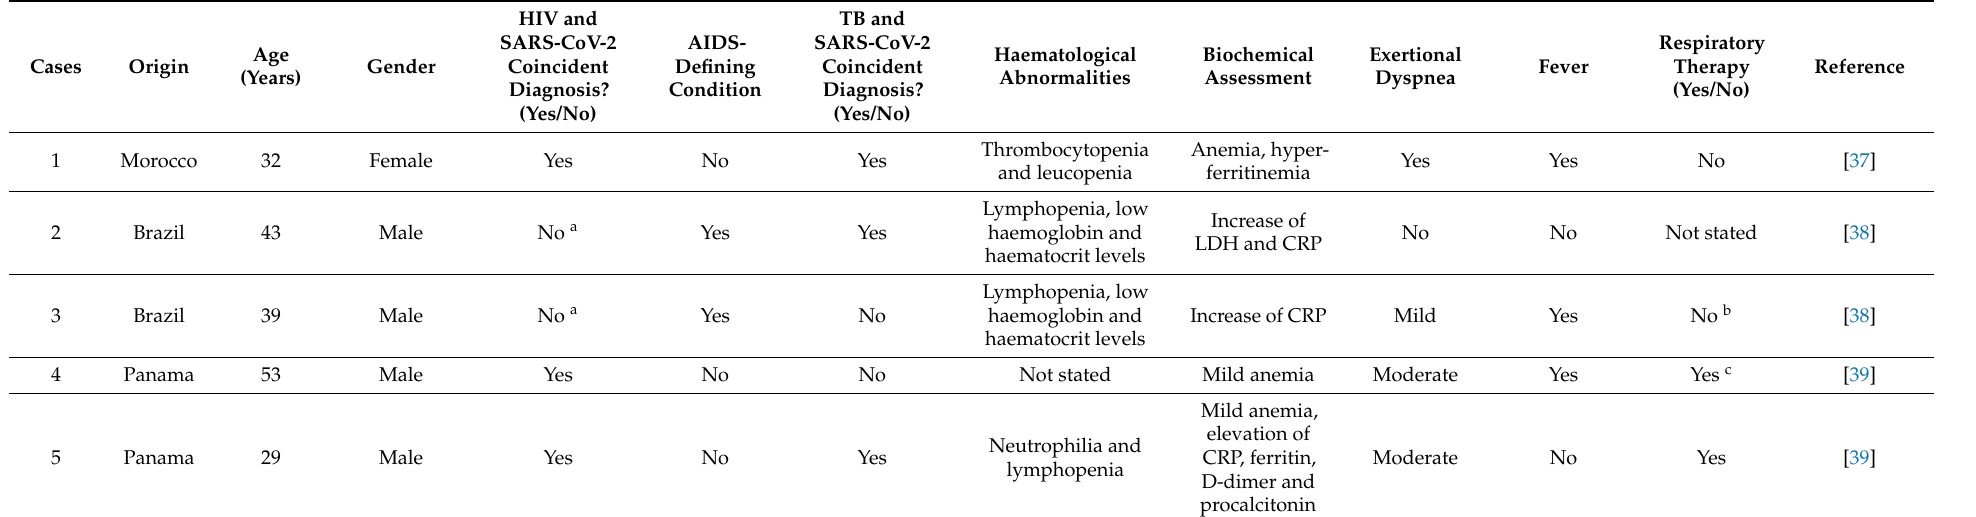
Table 1. Main characteristics of the 5 triple-infection cases